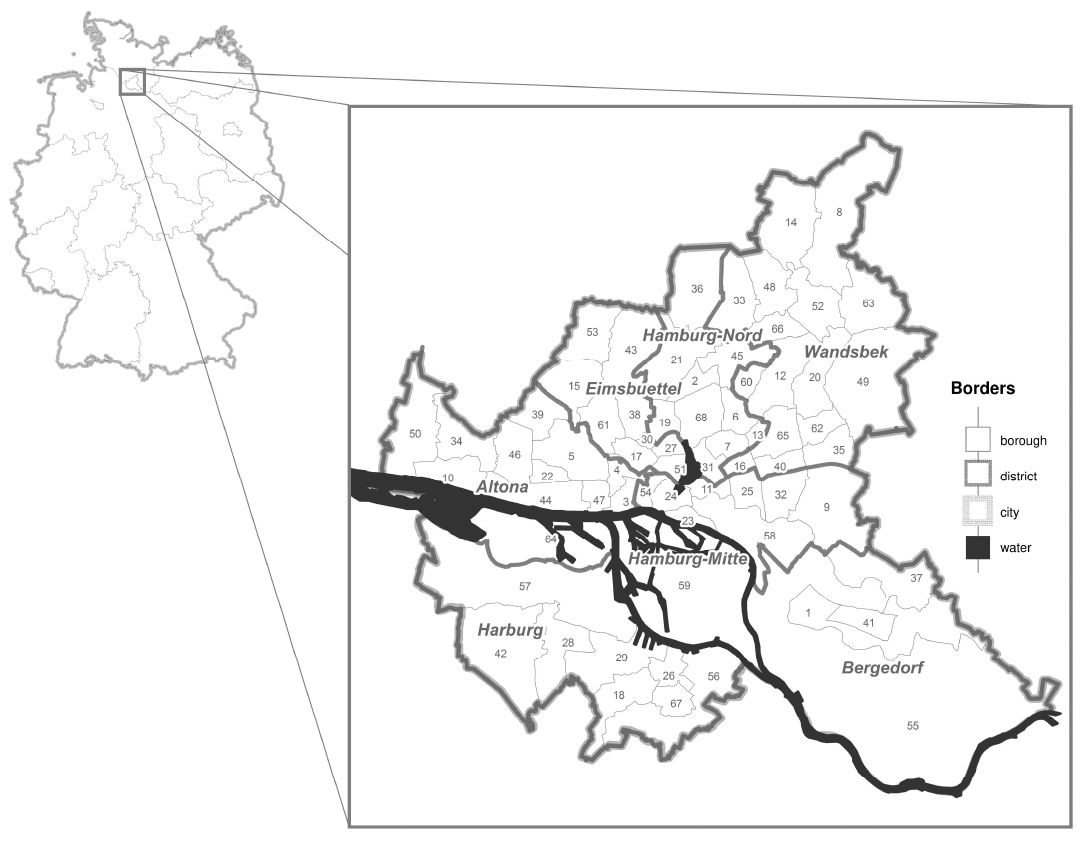
Figure 1. Map depicting the city of Hamburg. Detailed information about the boroughs can